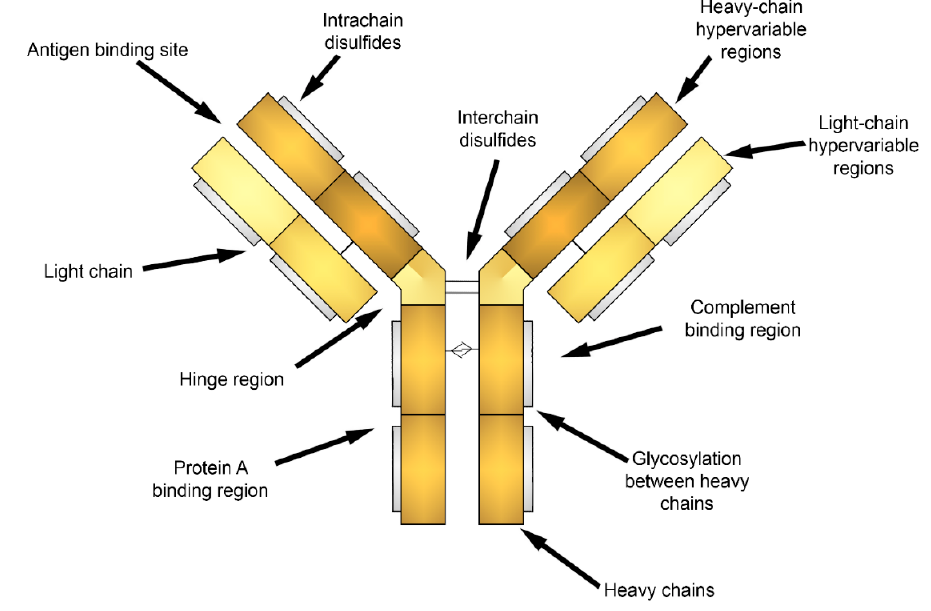
Figure 2. Sketch of an antibody structure.